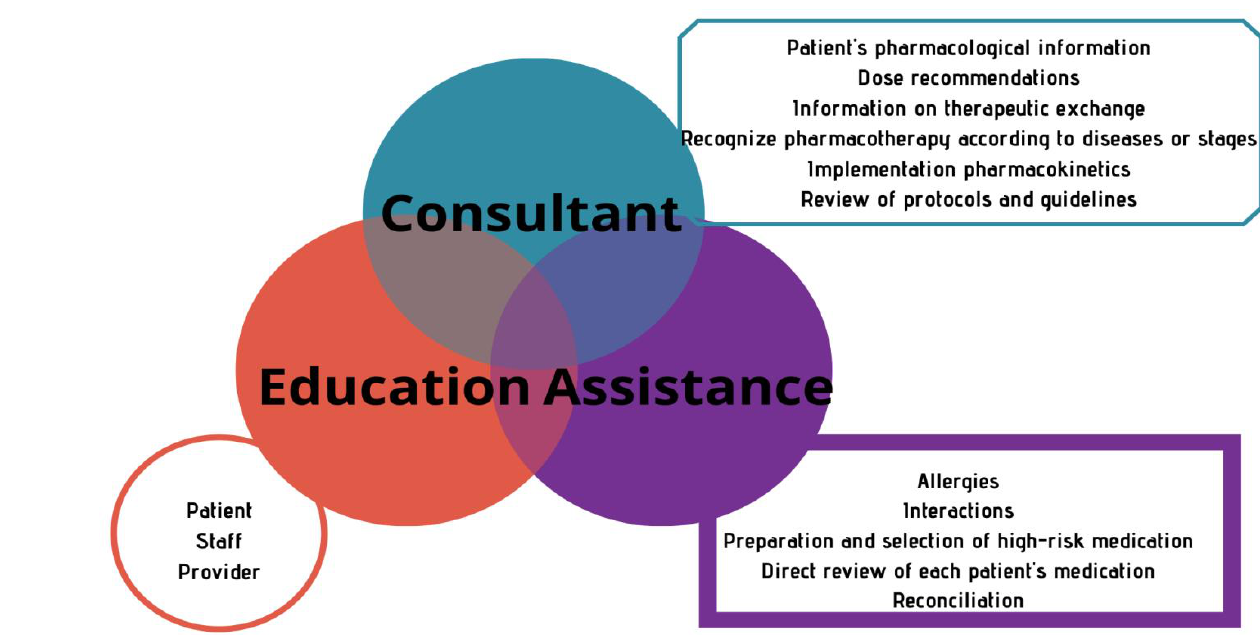
Figure 1: Extracted and modified from Eppert HD, Reznek AJ; American Society of Health-System Pharmacists. ASHP guidelines on emergency medicine pharmacist services. Am J Health Syst Pharm. 2011;68(23):e81-95. doi: